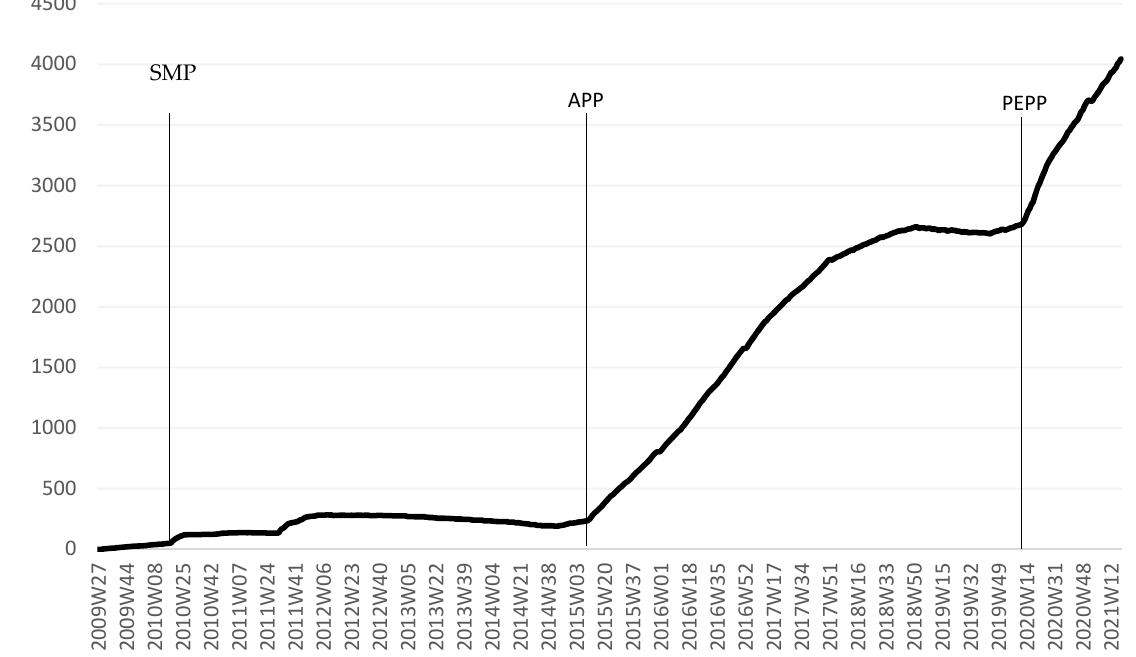
Figure 6. Eurosystem—Securities held for monetary policy purposes, in billions of Euro. Note: SMP—Securities Market Programme, APP—Asset Purchase Programme, PEPP—Pandemic Emergency Purchase Programme. Source: ECB, Statistical Data Warehouse. Data